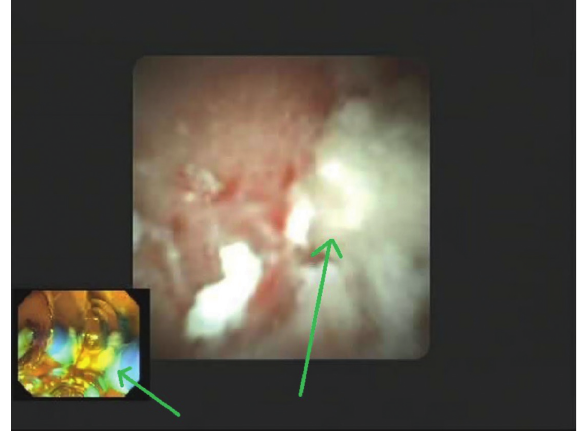
Figure 4: SpyGlass view and removal of PD